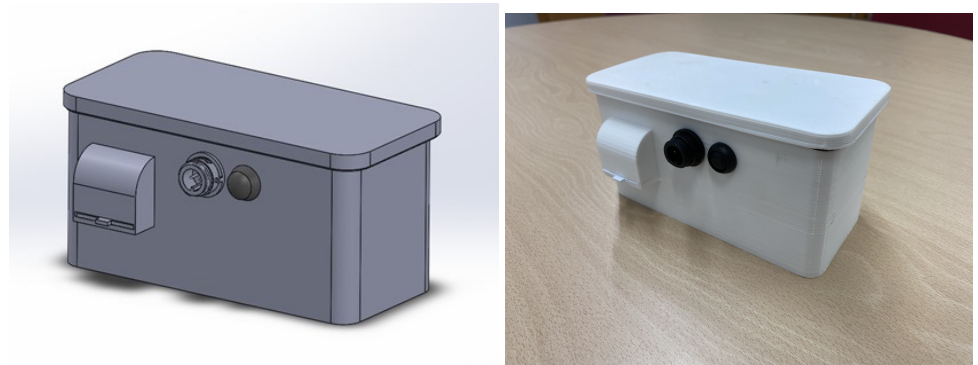
Figure 4. Polluting particle metering